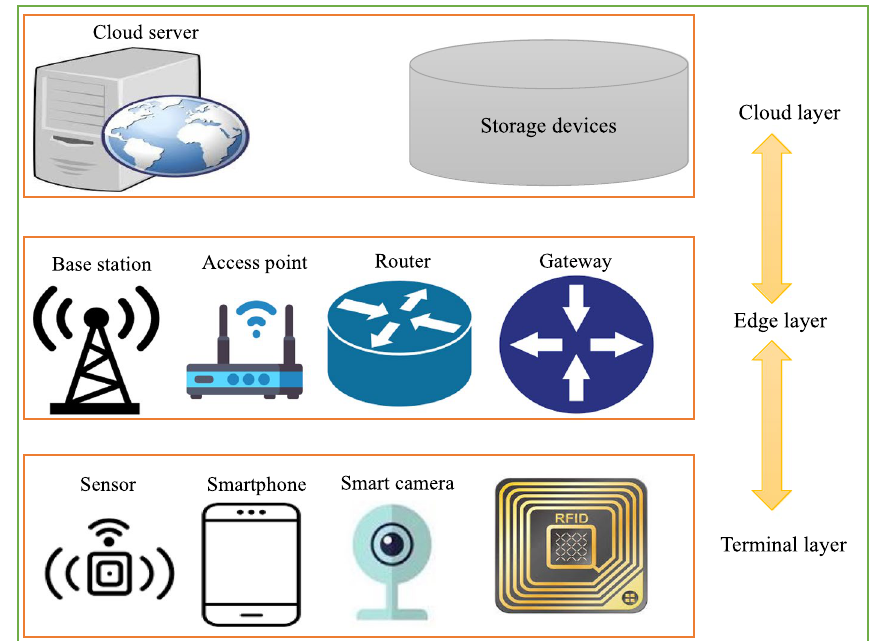
Fig. 2 Structure of cloud-edge collaboration for internet fraud governance